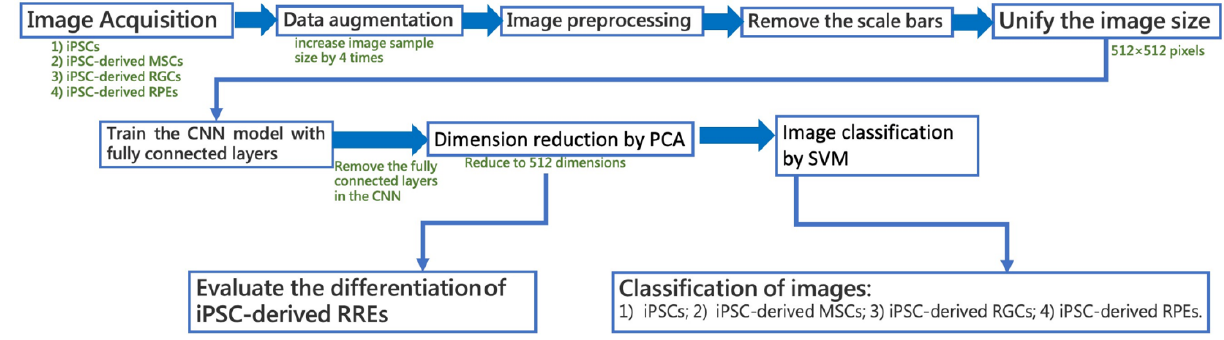
Figure 2. The training scheme of the neural network algorithm for the recognition of cell